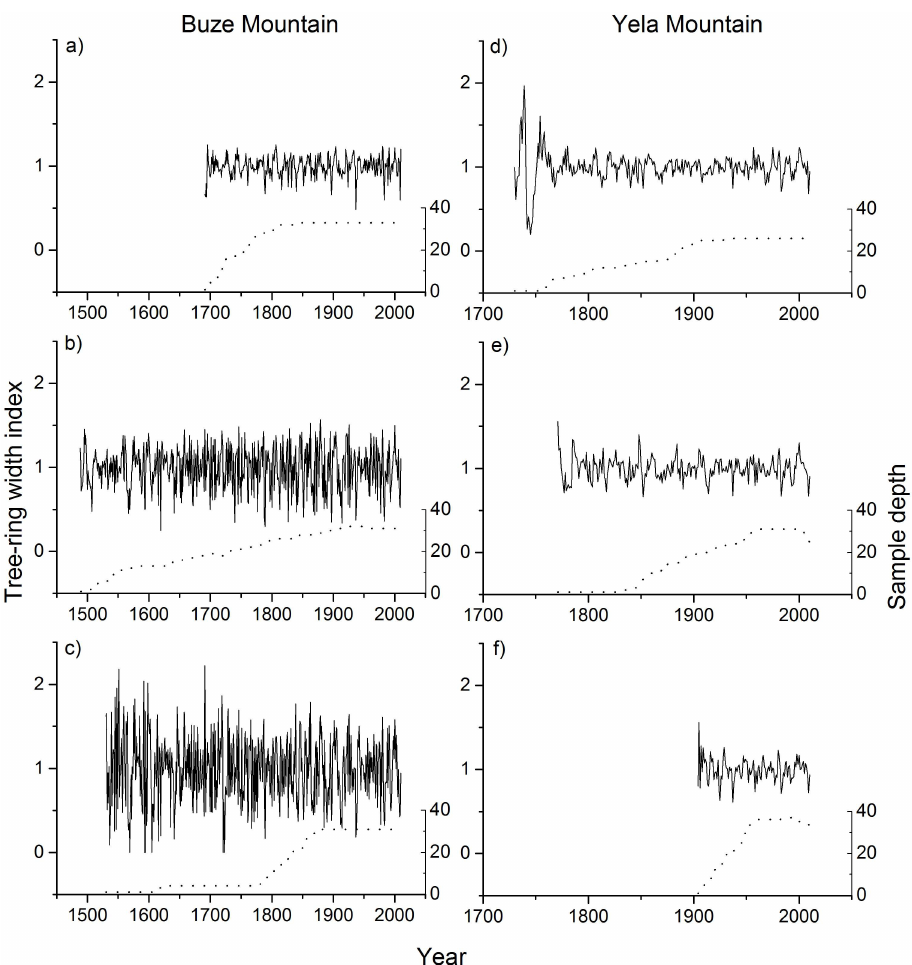
Fig 2. Tree-ring chronologies (solid line) for Buze Mountain (left panel) and Yela Mountain (right panel). a/d, b/e and c/f represent the upper, middle and lower elevationsites respectively. The dashedlines represent the numbers of tree-ring samples.